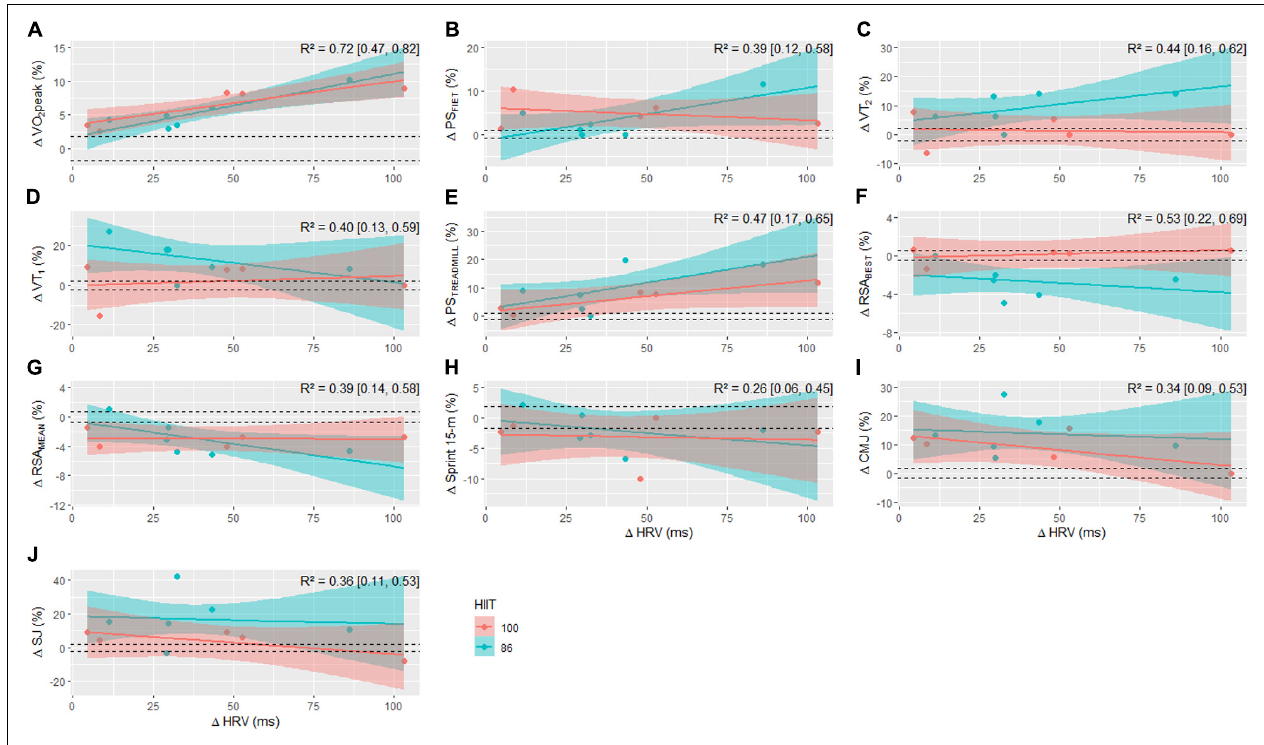
FIGURE 7 | Posterior regression medians with 90% credible intervals between pre-to-post changes in VO 2 peak (A) , PS FIET (B) , VT 2 (C) , VT 1 (D) , PS TREADMILL (E) , RSA BEST (F) , RSA MEAN (G) , Sprint 15-m (H) , CMJ (I) , and SJ (J) for each HIIT model with the pre-to-post change in HRV. R 2 , Bayesian variance explained. Horizontal dashed lines are the lower and upper boundaries of the ROPE (i.e., 0.2 × between subjects